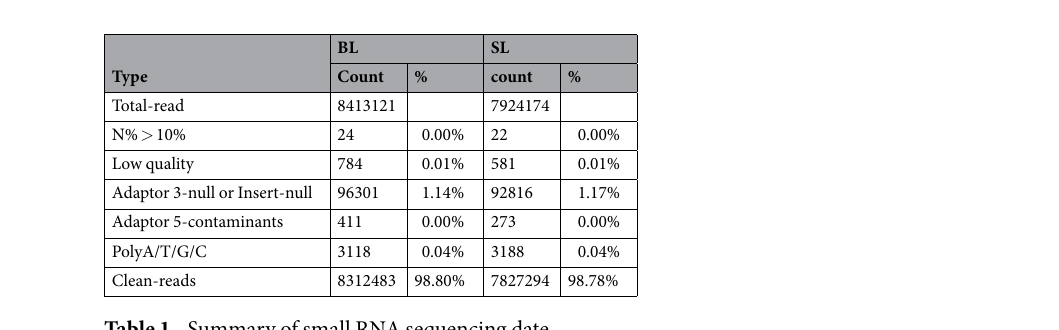
Table 1. Summary of small RNA sequencing